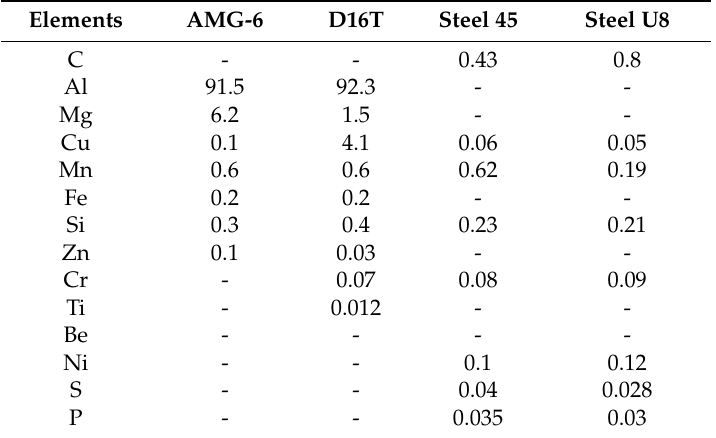
Table 1. The chemical compositions of the investigated materials, wt.